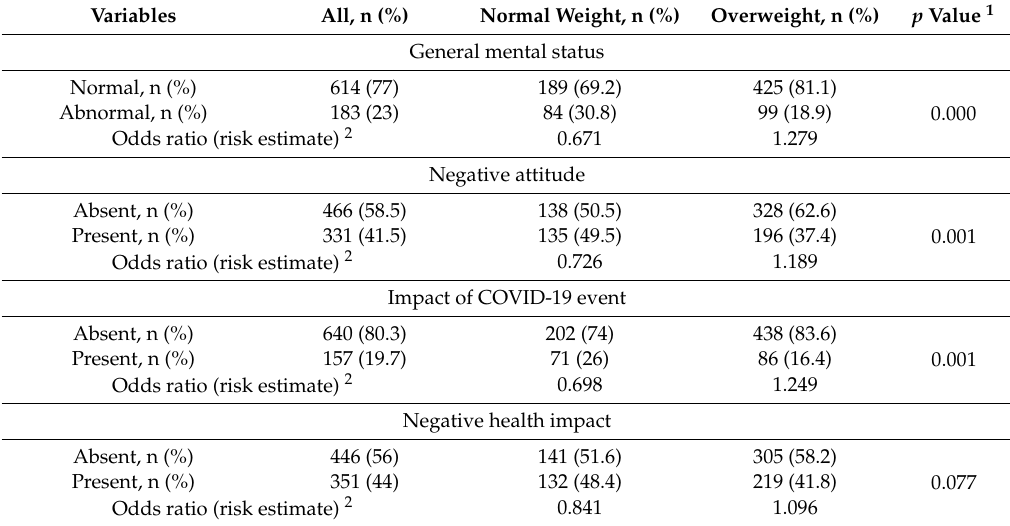
Table 3. General mental status, negative attitude, IES, negative health impact by body weight